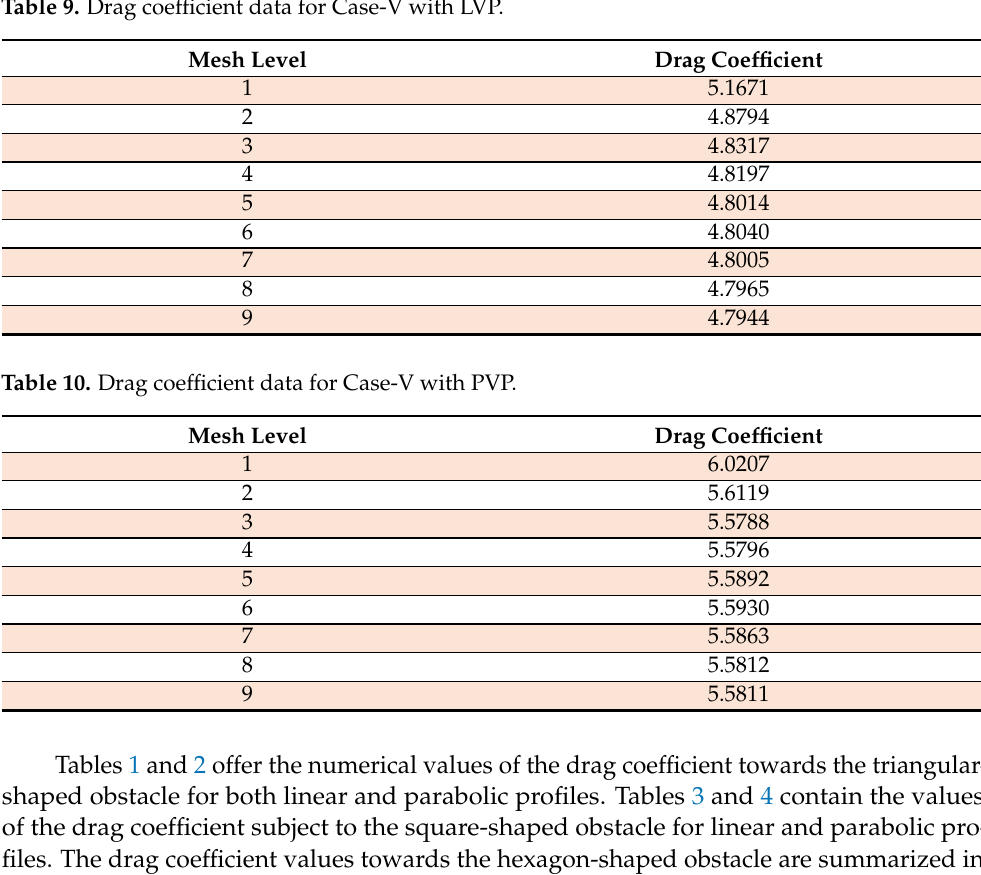
Table 9. Drag coefficient data for Case-V with LVP.